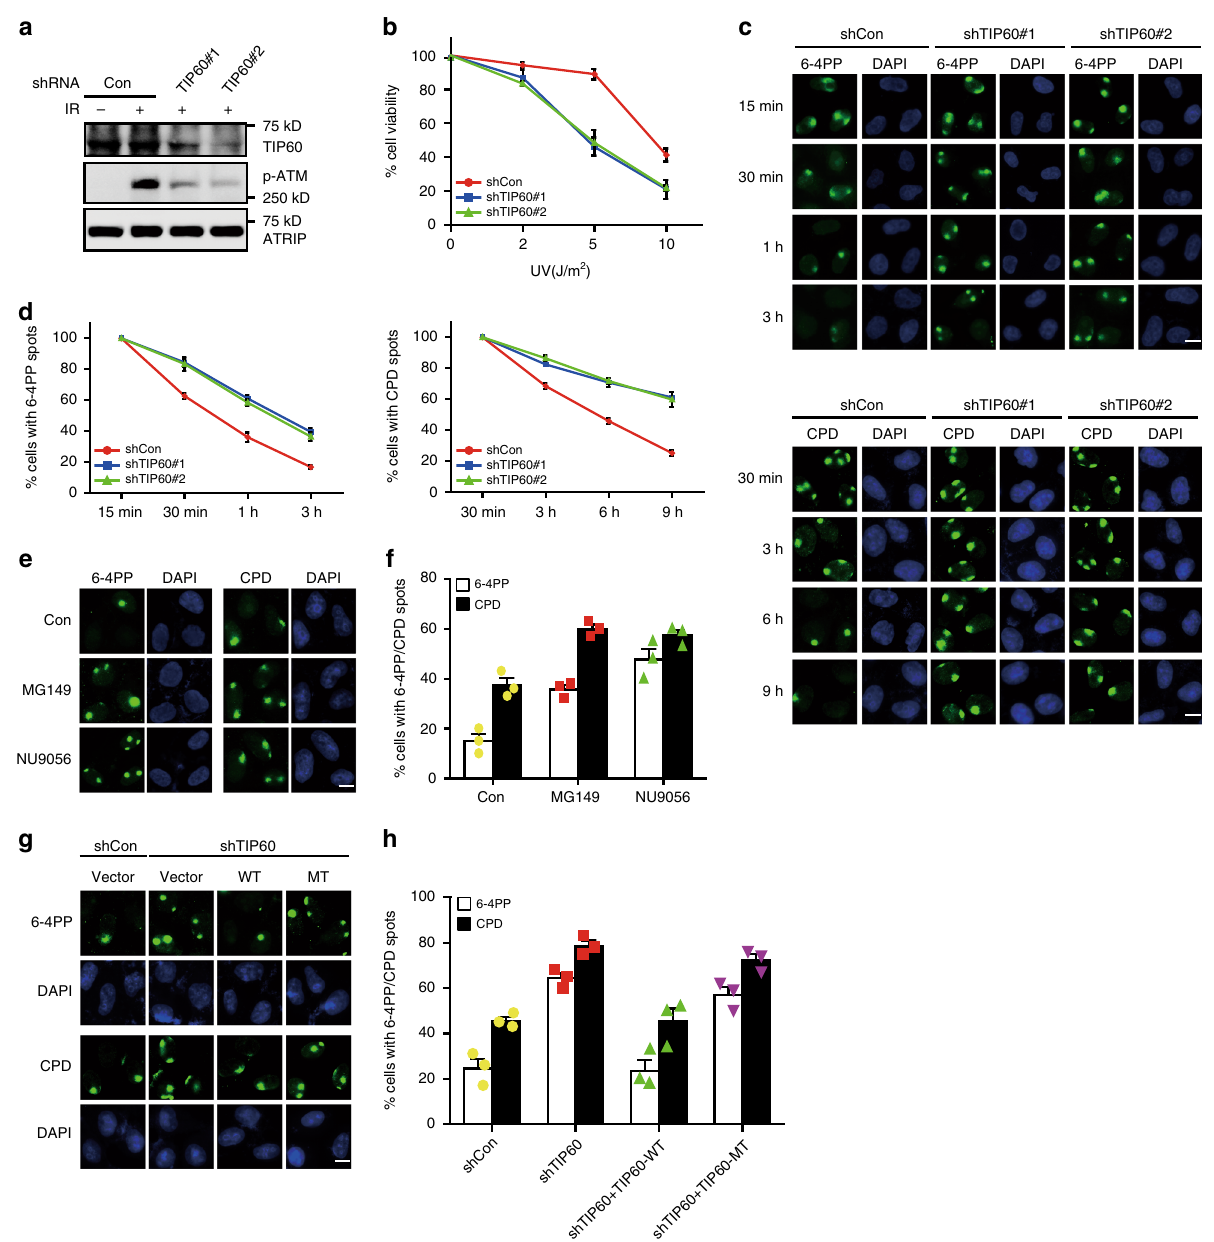
Fig. 1 TIP60 is required for ef fi cient NER. a , b HeLa cells were infected with lentiviral vectors expressing a control shRNA or TIP60-speci fi c shRNAs and cultured in medium containing puromycin (2 μ g ml − 1 ). The resulting cells were then treated with 5 Gy IR or indicated doses of UV. TIP60 Knockdown ef fi ciency was con fi rmed by immunoblotting ( a ). Clonogenic cell survival assays were performed in triplicates. Data represent means± SEM from three independent experiments ( b ). c , d TIP60 is essential for the repair of UV-induced DNA lesions. HeLa cells were infected with lentiviral vectors expressing a control shRNA or TIP60-speci fi c shRNAs and cultured in medium containing puromycin. The resulting cells were then irradiated with UV through 5-micron fi lters and allowed to recover for the indicated times before being stained with antibodies for 6-4PP or CPD ( c ). Data represent means± SEM from three independent experiments ( d ). More than 1000 6-4PP or CPD spots were counted for each condition. e , f The acetyltransferase activity of TIP60 is essential for NER. HeLa cells were either mock treated with DMSO or treated with TIP60-speci fi c inhibitors MG149 (100 μ M) or NU9056 (20 μ M) for 30 min before they were irradiated with UV through 5-micron fi lters and allowed to recover for 3 h (for 6-4PP) or 6 h (for CPD). Cells were then stained with antibodies for 6-4PP or CPD ( e ). Data represent means ± SEM from three independent experiments ( f ). More than 1000 6-4PP or CPD spots were counted for each condition. g , h A TIP60-depleted cell line stably expressing shRNA#2-resistant wild-type TIP60 or an acetyltransferase-defective mutant was generated. The resulting cells were irradiated with UV through 5-micron fi lters and allowed to recover for 3 h (for 6-4PP) or 6 h (for CPD) before being stained with antibodies for 6-4PP or CPD ( g ). Data represent means ± SEM from three independent experiments ( h ). More than 1000 6-4PP or CPD spots were counted for each condition. Scale bar, 10 μ m. Source data are provided as a Source Data fi